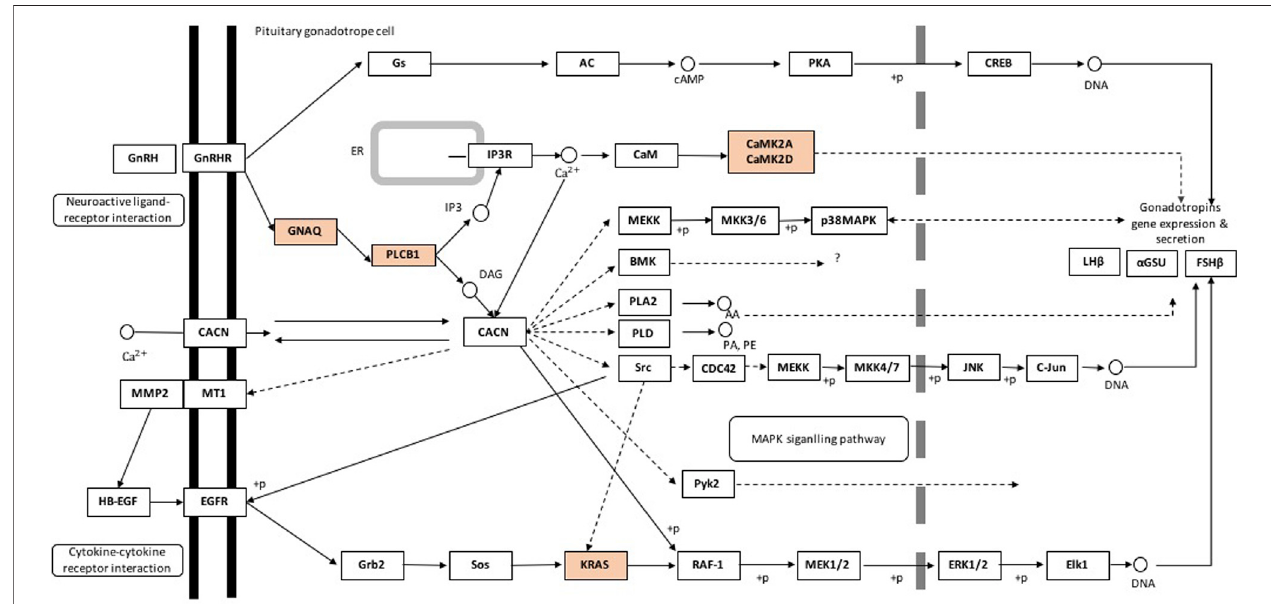
FIGURE5| Gonadotropin-releasinghormonesignallingpathwaycontainingdifferentiallyabundantproteinsinthehypothalamusofpre-andpostpubertalbrahman heifers.Pathwaycomponentsrepresentingdifferentiallyabundantproteinsareinorange.PathwaywasadaptedfromtheKEGGdatabase(http://www.genome.jp/kegg- bin/show_pathway?bta04912, accessed: 11/03/2018).